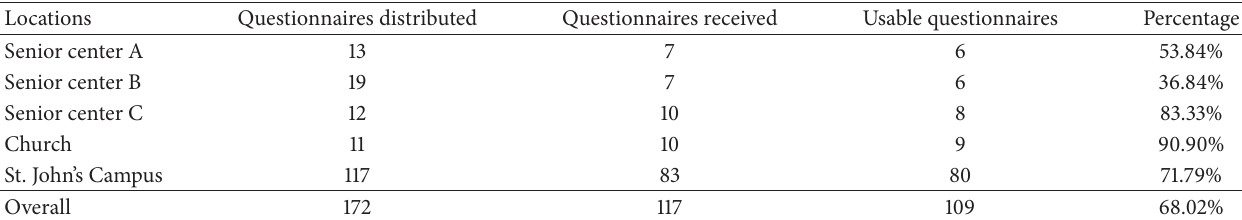
Table 1: Responses obtained from different research